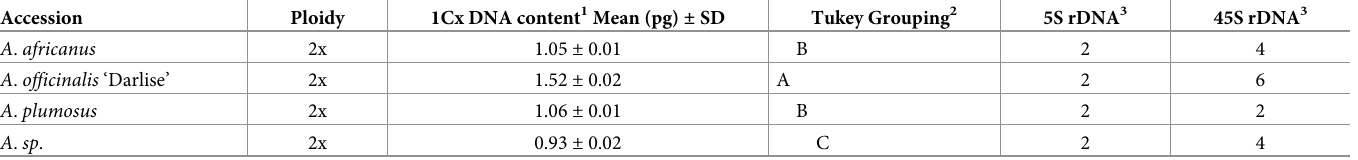
Table 4. Asparagus accessions with their calculated 1Cx DNA content estimated with flow cytometry using P . sativum as internal standard and their number of 5S and 45S rDNA loci.